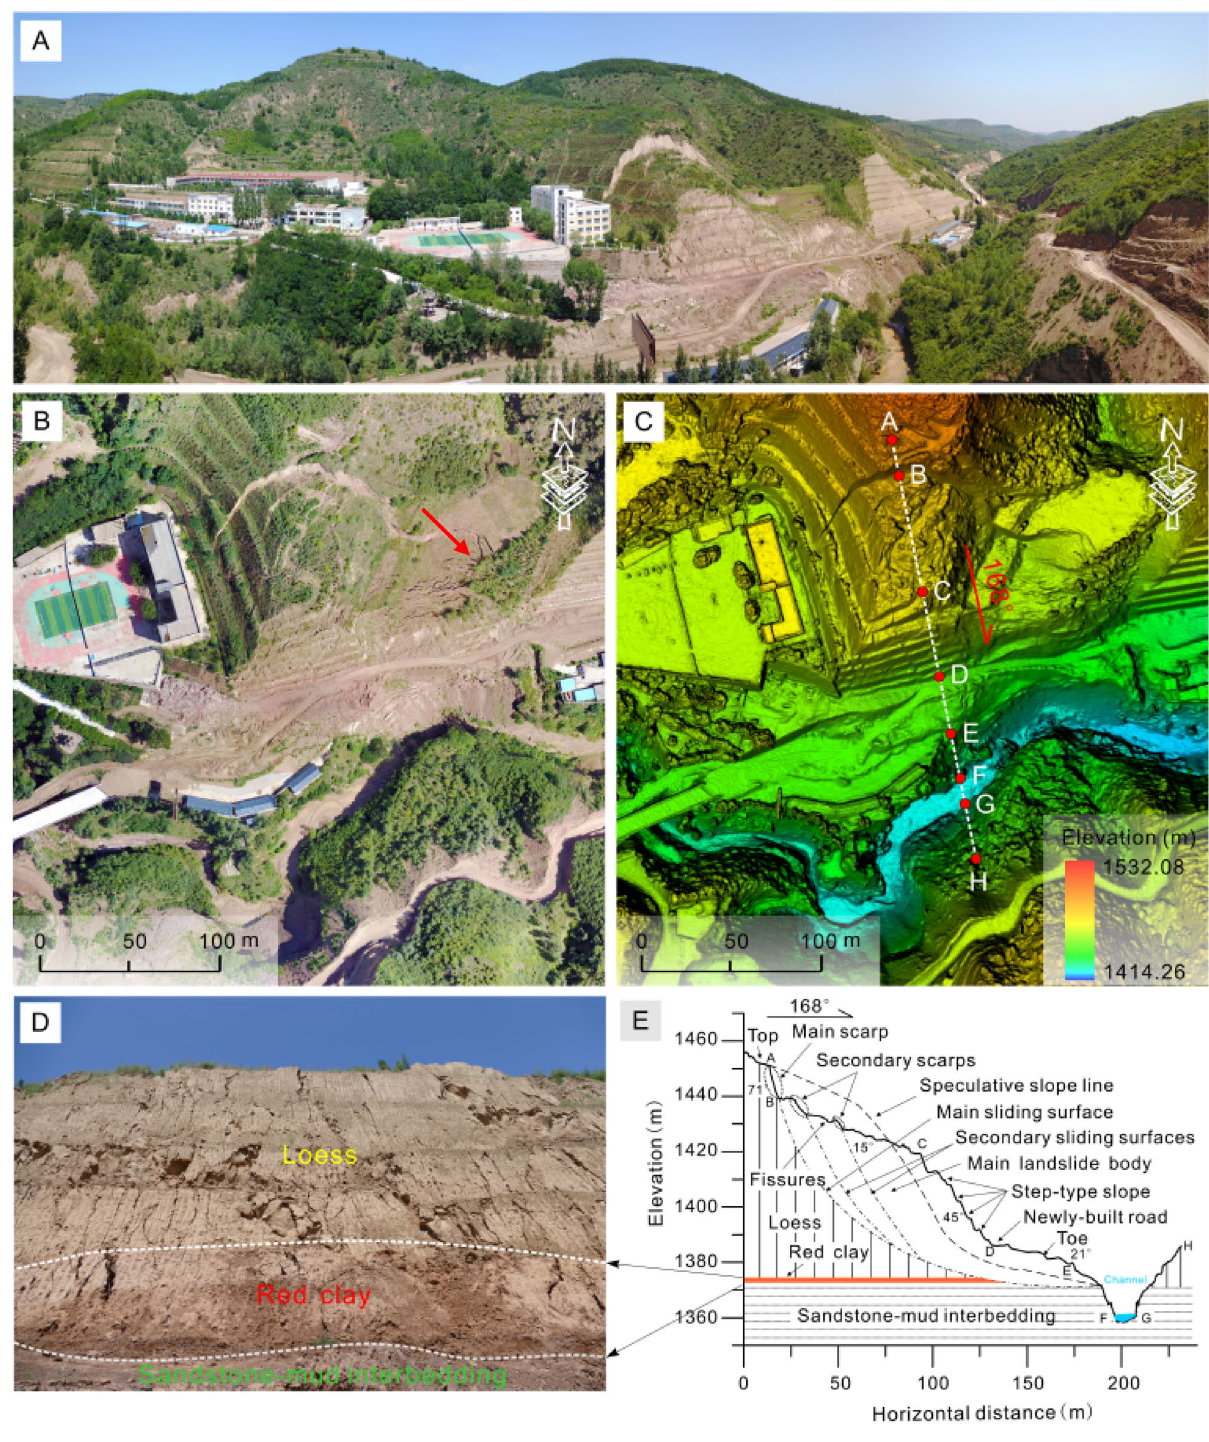
Figure 1. Loess-red clay landslide in Zhifang village elementary school. ( a ) Overview of landslide; ( b ) landslide crack; ( c ) DEM image of landslide; ( d ) landslide stratum; ( e ) sectional view of the main sliding direction of the